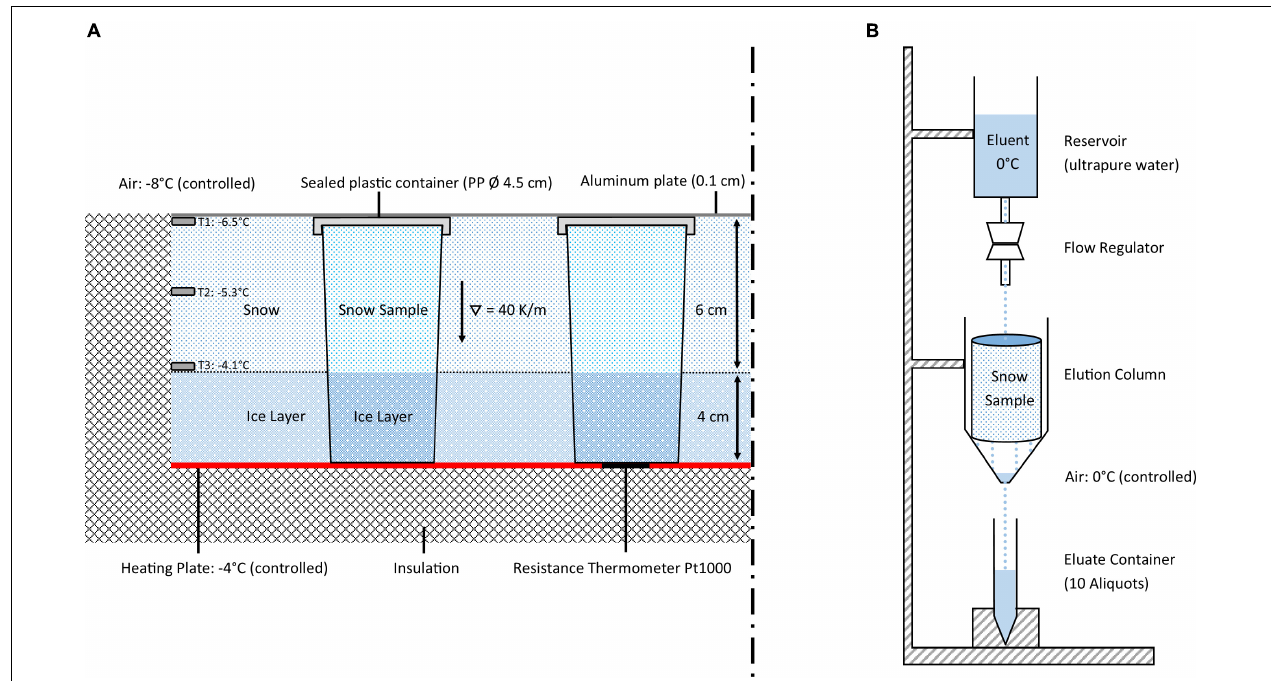
FIGURE 1 | (A) Scheme of the metamorphism box showing two sample containers (28 samples were stored). (B) Scheme of the elution setup. This setup was installed in the laboratory at 0 ◦ C, a total of three elution stations could be run simultaneously.